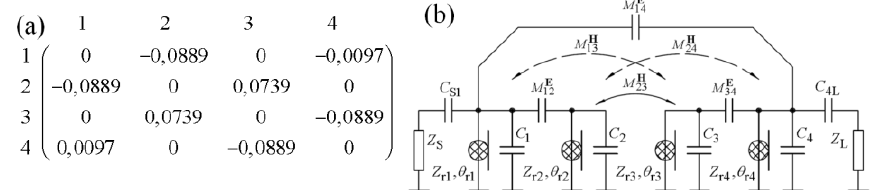
Fig. 7. Coupling matrix of the proposed QEF on MCB (a) and its equivalent circuit